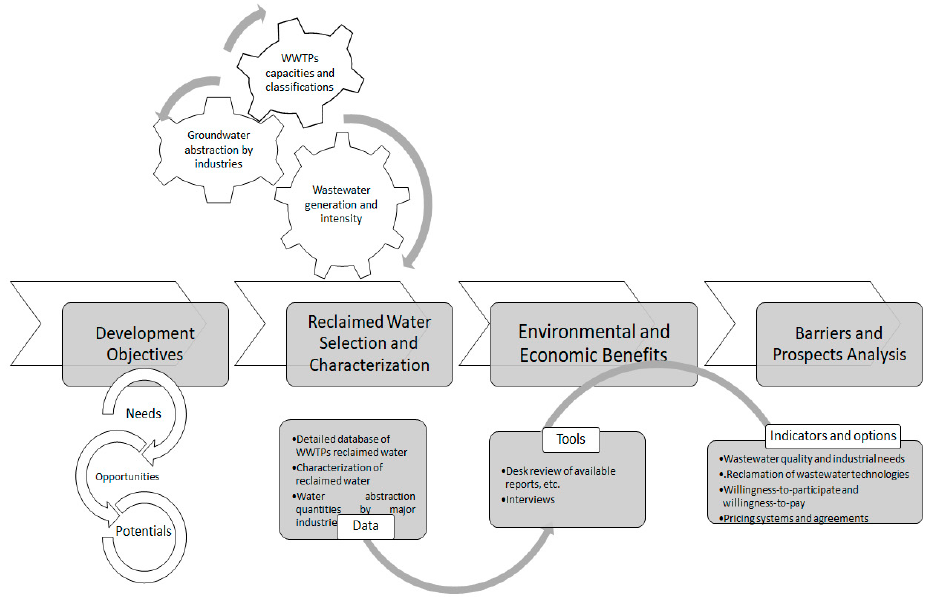
Figure 3. Diagram of the framework.